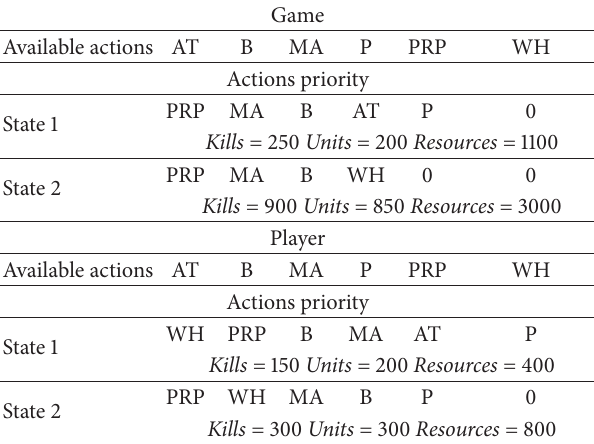
Table 4: LSCAPI three towers